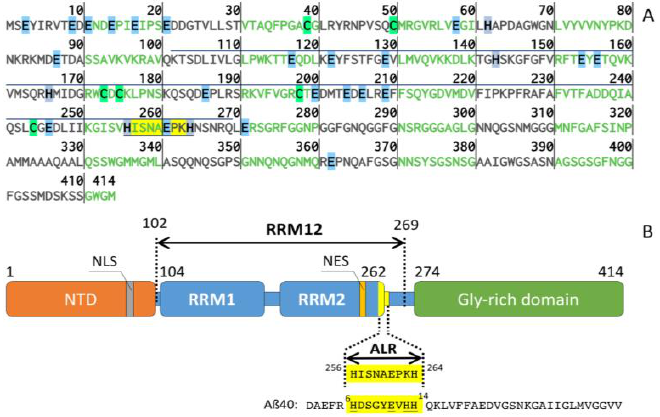
Figure 1. ( A ) Primary sequence of TAR DNA-binding protein 43 (TDP-43). The fragments of 102–269 (RRMs) and 256–264 (ALR) discussed in this study overlined and underlined respectively. The amino acids, which are able to chelate Zn 2+ ions are highlighted: in clear blue—Glu, in green—Cys and in grey—His. ( B ) Domain organization of TDP-43: NTD—N-terminal domain; NLS—nuclear localization sequence; RRM1 and RRM2—RNA-recognition domains; NES—nuclear export signal. ALR in TDP-43 and A β 40 sequence highlighted in yellow, amino acids that chelate Zn 2 + in A β 40 are